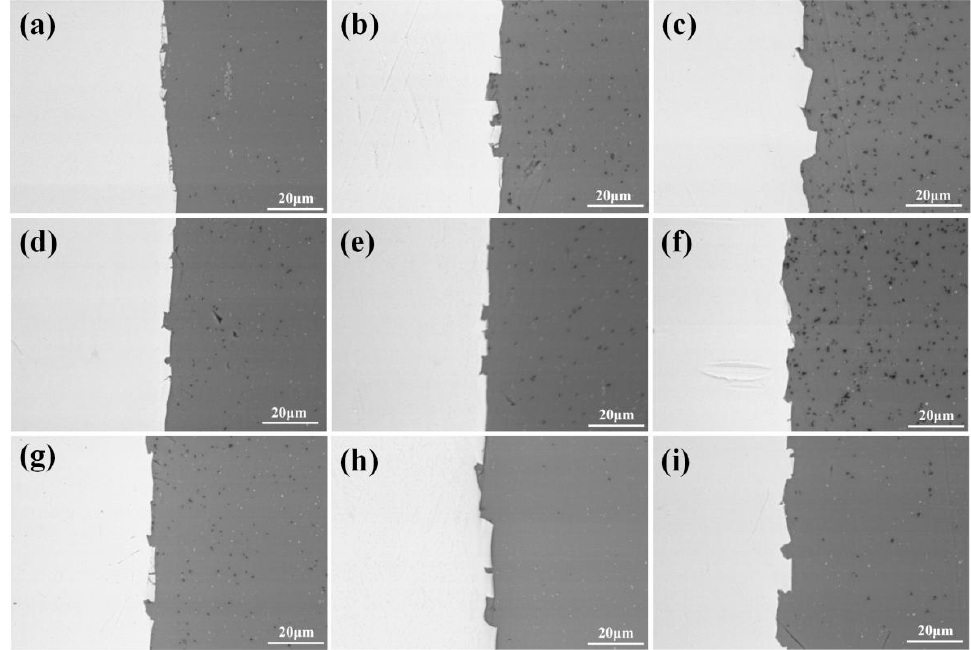
Figure 14. SEM micrographs of the interface of the Ti/Al composite sheet. ( a ) Specimen B1; ( b ) spec- imen B2; ( c ) specimen B3; ( d ) specimen A1; ( e ) specimen A2; ( f ) specimen A3; ( g ) specimen C1; ( h ) specimen C2; ( i ) specimen C3.